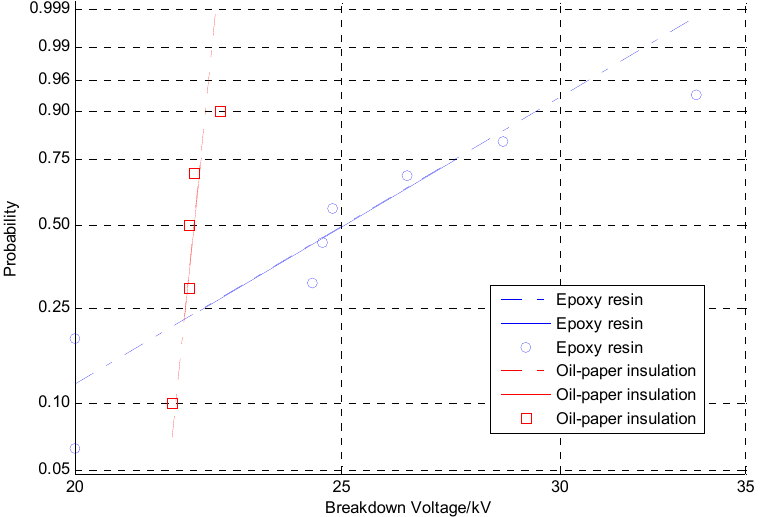
Figure 9. Weibull probability plot.